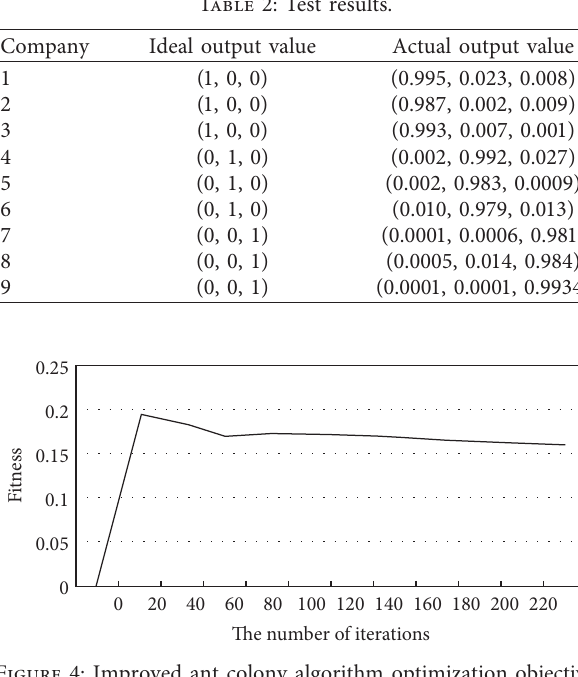
Table 2: Test results.